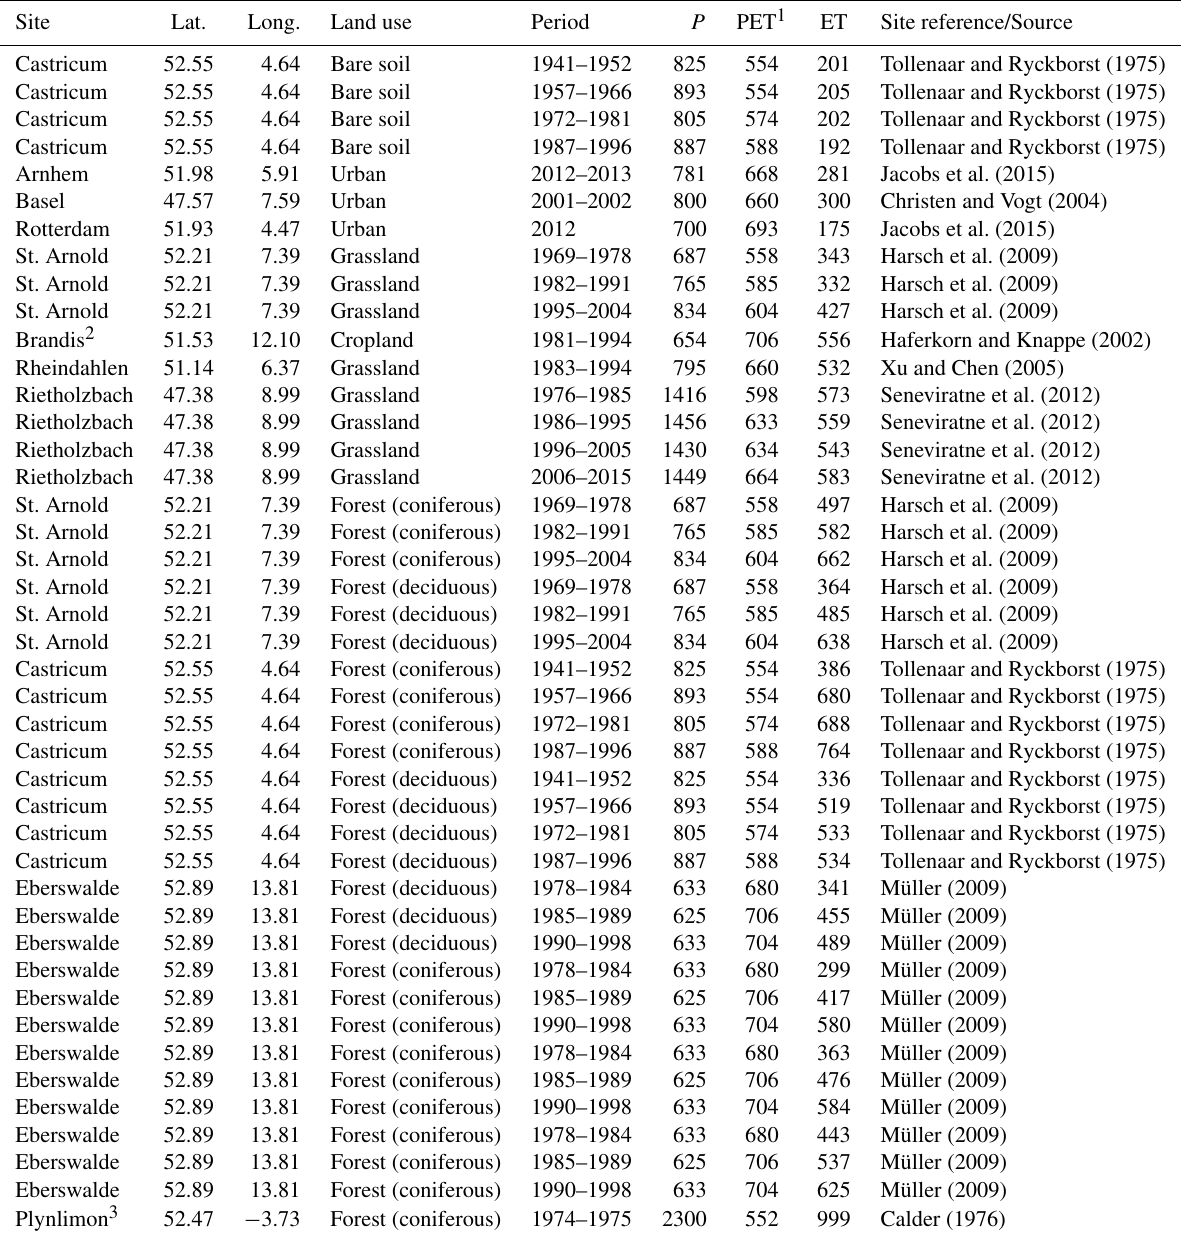
Table 1. Data used in the Budyko analysis. Units of fluxes are in mmyr − 1 .